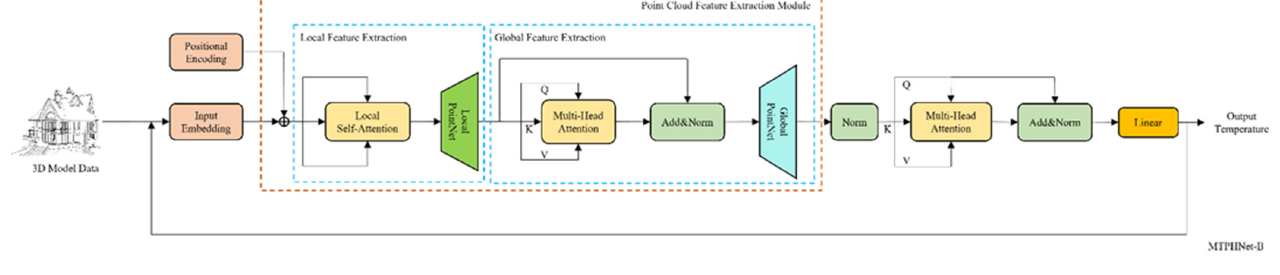
Table 5. Quantitative evaluation metrics of MTPHNet and its variants. All models follow the same procedure and training environment as described in Section 4.1 and are evaluated on the same test set. The best results are shown in bold.